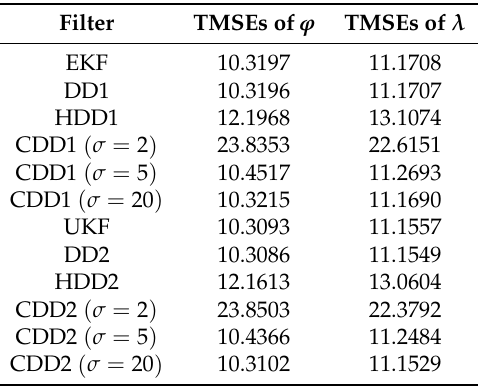
Table 3. TMSEs of position in Gaussian noises.